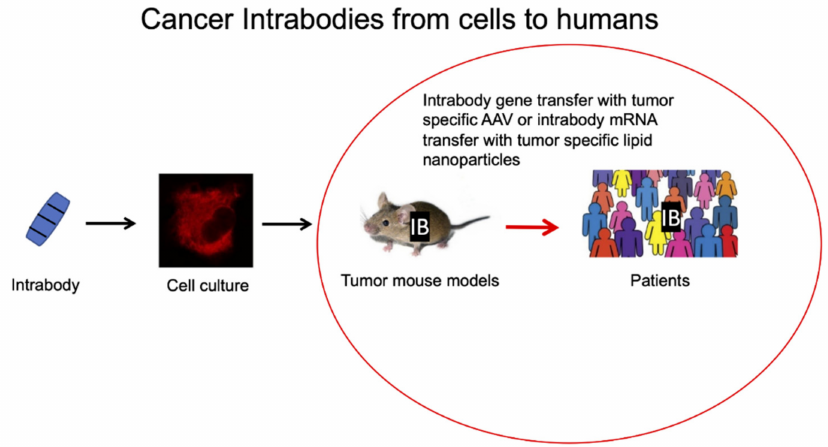
Figure 2. Bench-to-bedside development of anti-cancer intrabodies with the initial demonstration of tumor growth inhibition in appropriate in vitro and in vivo xenograft tumor mouse